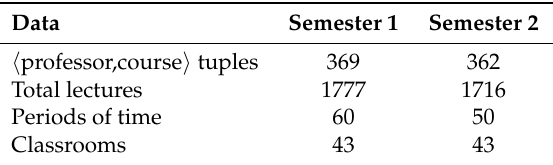
Table 3. Data of the two test semesters for the TTP stage.